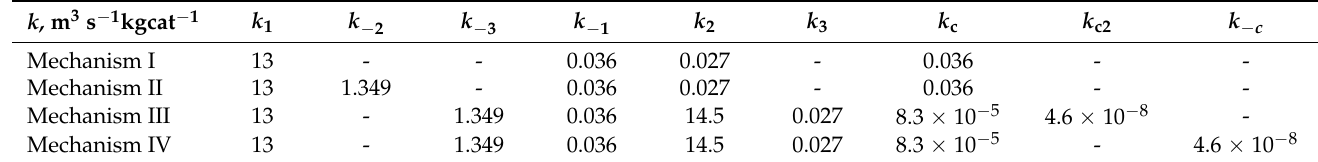
Table 1. Input values for kinetic